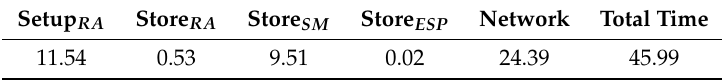
Table 2. Breakdown of execution time of the registration stage (milliseconds).